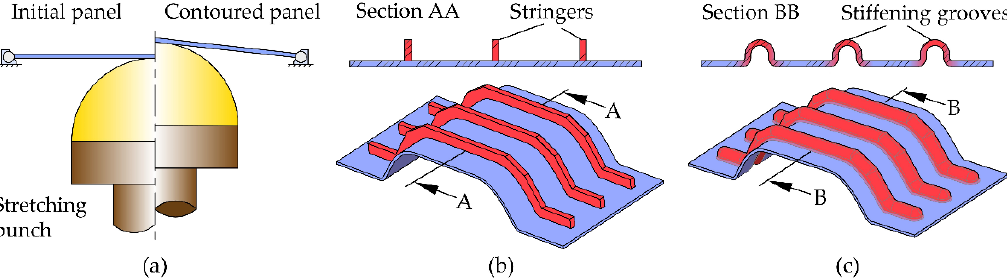
Figure 1. ( a ) Fabrication of sheet metal panels by stretching; strengthening of sheet metal panels by ( b ) longitudinal stringers and by ( c ) longitudinal stiffening grooves.